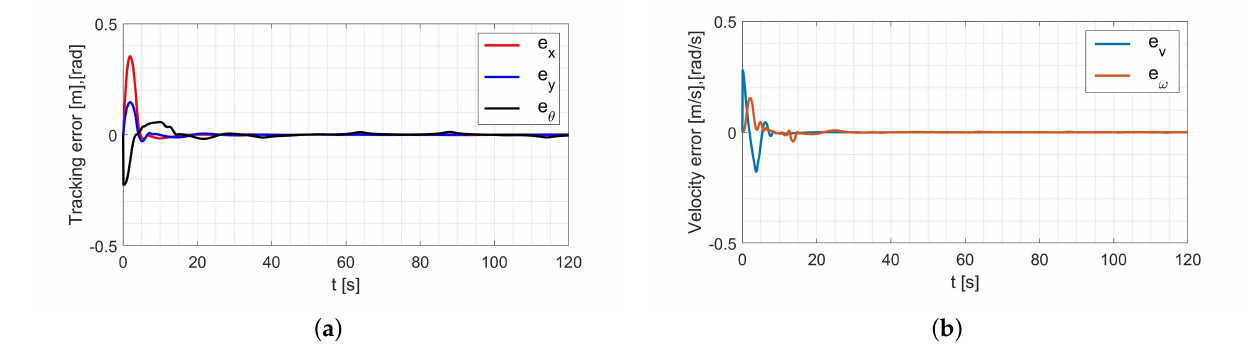
Figure 13. Errors for the RLS method with initial parameters determined by the Levenberg-Marguardt method: ( a ) tracking the reference trajectory ( b )